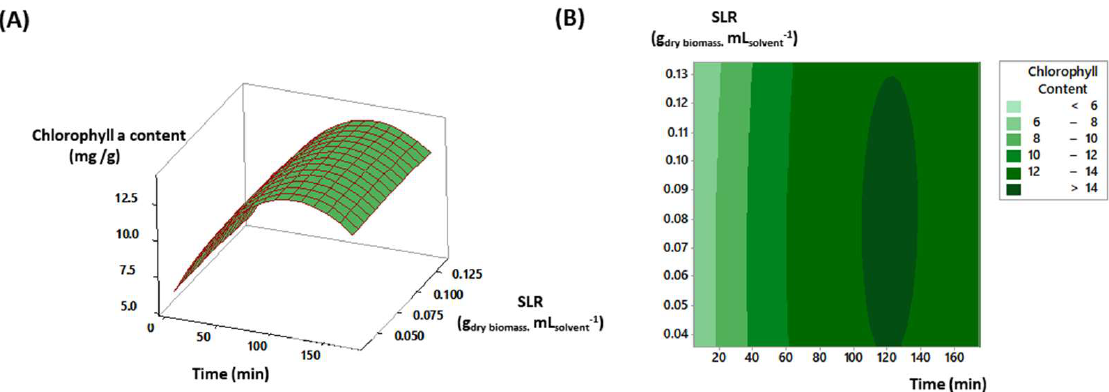
Figure 2. ( A ) Response surface plot and ( B ) contour of the CCRD 2 2 obtained for the combined effect of SLR and time of extraction optimization using 95% ethanol as solvent.